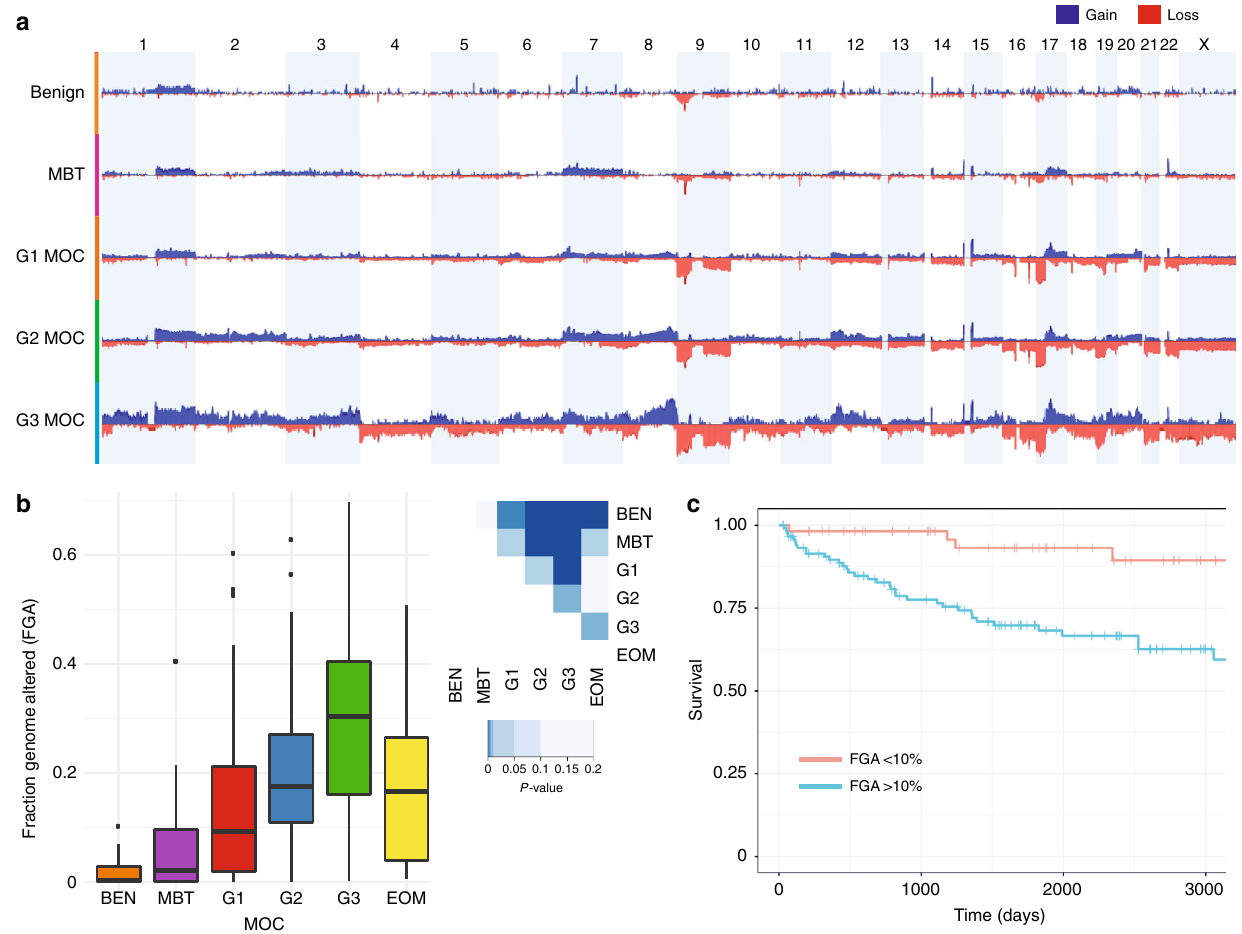
Fig. 2 Copy number analysis. a Comparison of copy number frequency across the genome, comparing benign (BEN), borderline (MBT), MOC grade 1 (G1), grade 2 (G2) and grade 3 (G3). b Fraction of the genome altered (FGA) by group including extra-ovarian (EOM) mucinous tumors (ANOVA, two-sided p < 0.001, F = 17.0, df = 5). Tukey post-test comparison p -values shown at right (two-sided). Error bars are “ Tukey ” (geom-boxplot in ggplot2). c MOC disease-speci fi c survival by FGA. Score (logrank) test = 11.98 on 1 df, p =